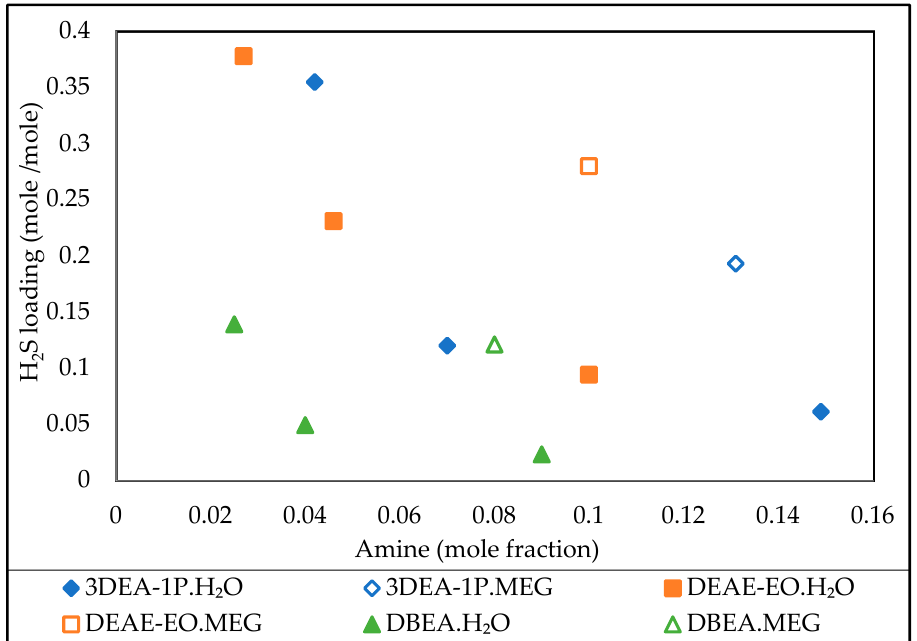
Figure 10. Effect of amine (mole fraction) on H 2 S loading; T = 5 °C ± 0.1 °C; pH 2 S = 1 kPa; DBAE solutions makes two phases.